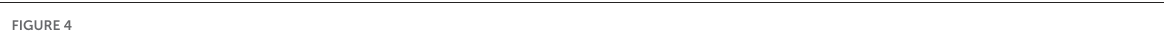
FIGURE4 deionized water or GRP aqueous solutions. GPR, ginsenosides-extracting residue polysaccharides; Control (black columns), fruits treated with deionized water; L-GRP (gray columns) and H-GRP (white columns), fruits treated (coated) with GRP at 5 and 20 mg/ml in respective; TA, titratable acidity; and SS, soluble solids. The depth of the legend color represents the size of the corresponding value. Results were presented as mean ± SD of three independent experiments ( n = 3). Different lower-case and upper-case letters indicate significant differences between and within groups, respectively, at p < 0.05 based on Tukey